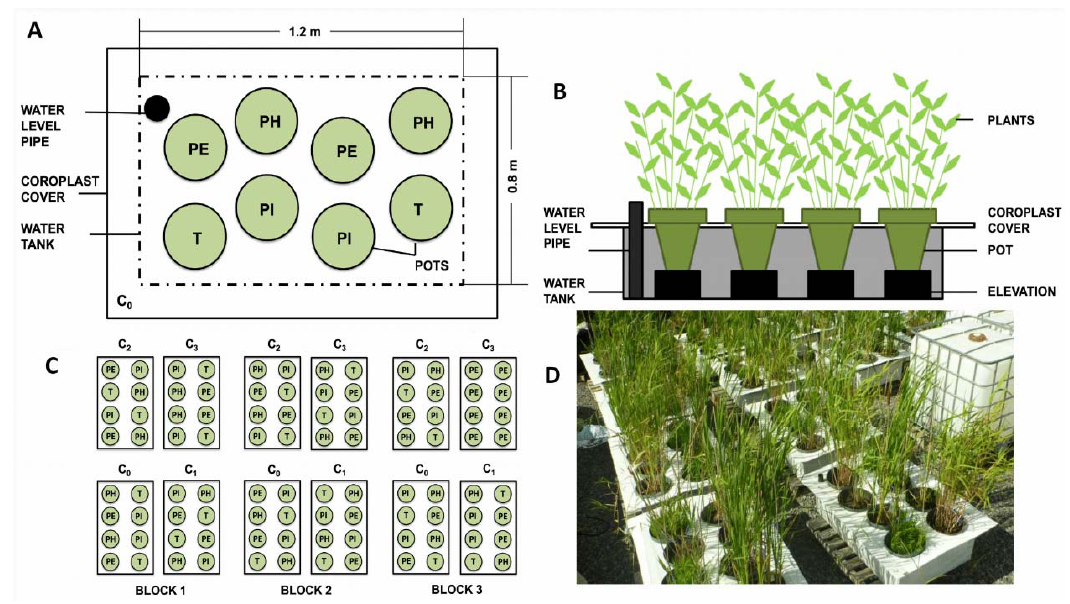
Figure 4. The experimental setup: ( A ) an aerial and ( B ) a side view of a tank, ( C ) the experimental design; ( D ) picture of the experiment. (PH) Phalaris arundinacea ; (PE) Phragmites australis subsp. australis ; (PI) Phragmites australis subsp. americanus ; (T) Typha angustifolia . The four concentrations of leachates are marked with C 0 (uncontaminated), C 1 –C 3 (lowest to highest